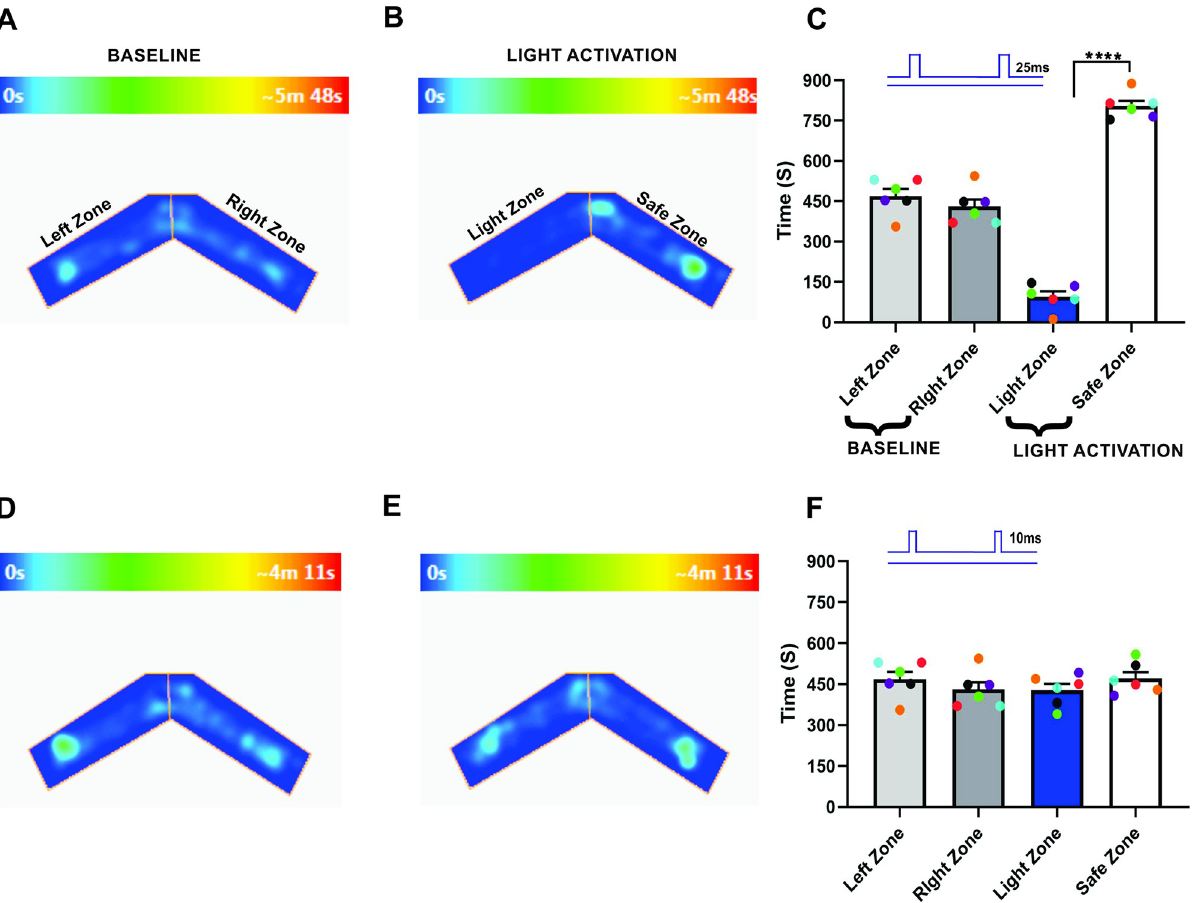
Fig 2. Stimulus duration changes the olfactory information. A, B, an example of heat-map showing the animal’s position in the “two-arms maze” during baseline (A) and 25 ms unilateral light stimulation (B). C, Average amount of time explored in each zone in baseline (Left zone, Right Zone) and 25 ms unilateral light stimulation trials (Light zone, Safe zone). D, E, Heat-map of mouse position during baseline (D) and 10 ms unilateral light stimulation (E). F, Average amount of time spent in each zone in baseline and 25 ms unilateral light stimulation trials. ( ���� P < 0.0001, n = 6 animals, Heat map generated by ANY-maze version 5.2, https://www.anymaze.co.uk/index.htm). of the “two-arms maze” after the foot shock training. Our baseline data show that the mice spent nearly equal amounts of time in both arms of the “two-arms maze” (Left zone— 469.3 ± 26.73 s, Right zone- 430.7 ± 26.73 s, P = 0.50, Fig 2A, S1 Movie, n = 6). Then, we unilat- erally stimulated the OB with 25 ms duration light pulses with an interval of 150 ms. We found that the mice avoided the Light zone during 25 ms OB stimulation and spent most of their time in the Safe zone (Light zone—94.75 ± 19.47 s, Safe zone—805.3 ± 19.47 s, P = < 0.0001, Fig 2B and 2C, S2 Movie, n = 6). We also tested whether the avoidance response to the light stimulation was equally probable in both arms of the “two-arms maze”. To confirm this, in some trials we delivered light stimulation when the mice reached the Safe zone. We found that the mice avoided the Safe zone during the light stimulation, indicating that the avoidance response is clearly linked to olfactory information, but not to spatial information. Next, we stimulated the OB with 10 ms duration light pulses. Here, we found that the time spent in each arm during the baseline behavior trial (Left zone—469.3 ± 26.73 s, Right zone—430.7 ± 26.73 s, P = 0.50, Fig 2D, n = 6) and the light activation trial (Light zone—